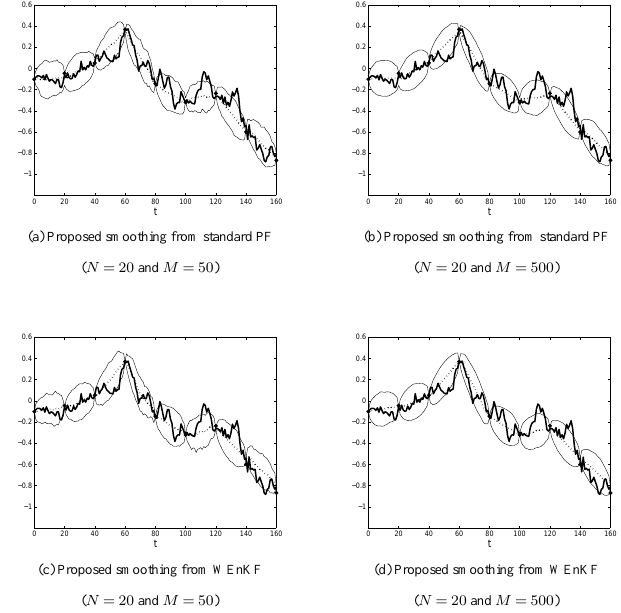
Figure 4. Proposed conditional smoothing result. Thick line: hidden Fig. 4: Proposed conditional smoothing result. Thick line: hidden diffusion; Dots: partial observations; Dotted diffusion; dots: partial observations; dotted line: estimated back- line: estimated backward smoothing mean; Thin line: estimated standard deviation. ward smoothing mean; thin line: estimated standard